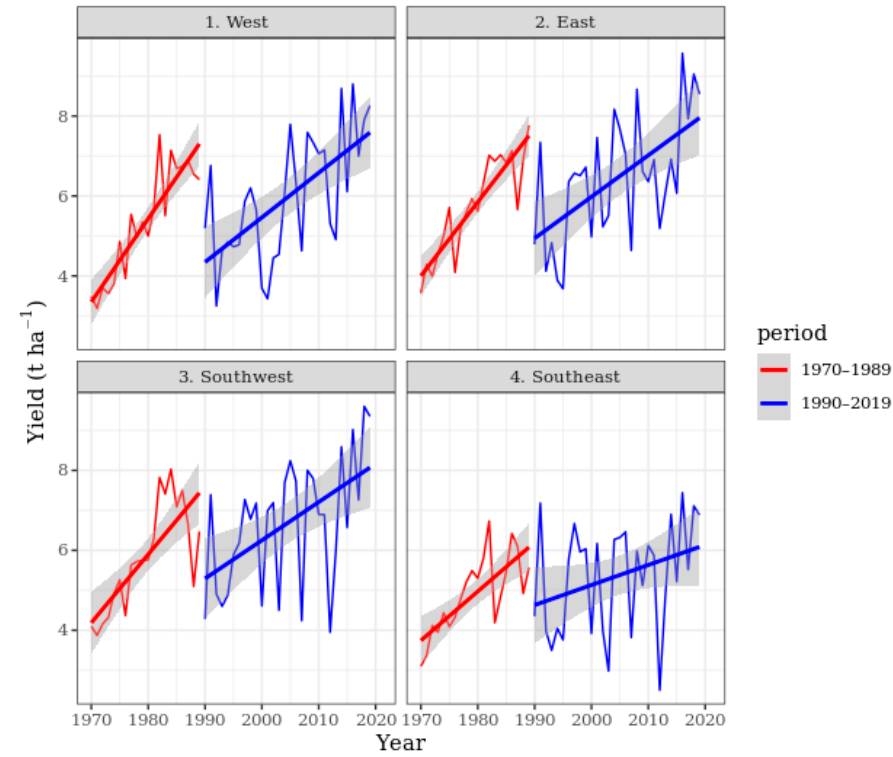
Figure 5. Average yields of maize in the four investigated regions divided into two periods (1970–1990 and 1991–2019). The grey strips indicate the 95% confidence intervals representing the correctness of fit.